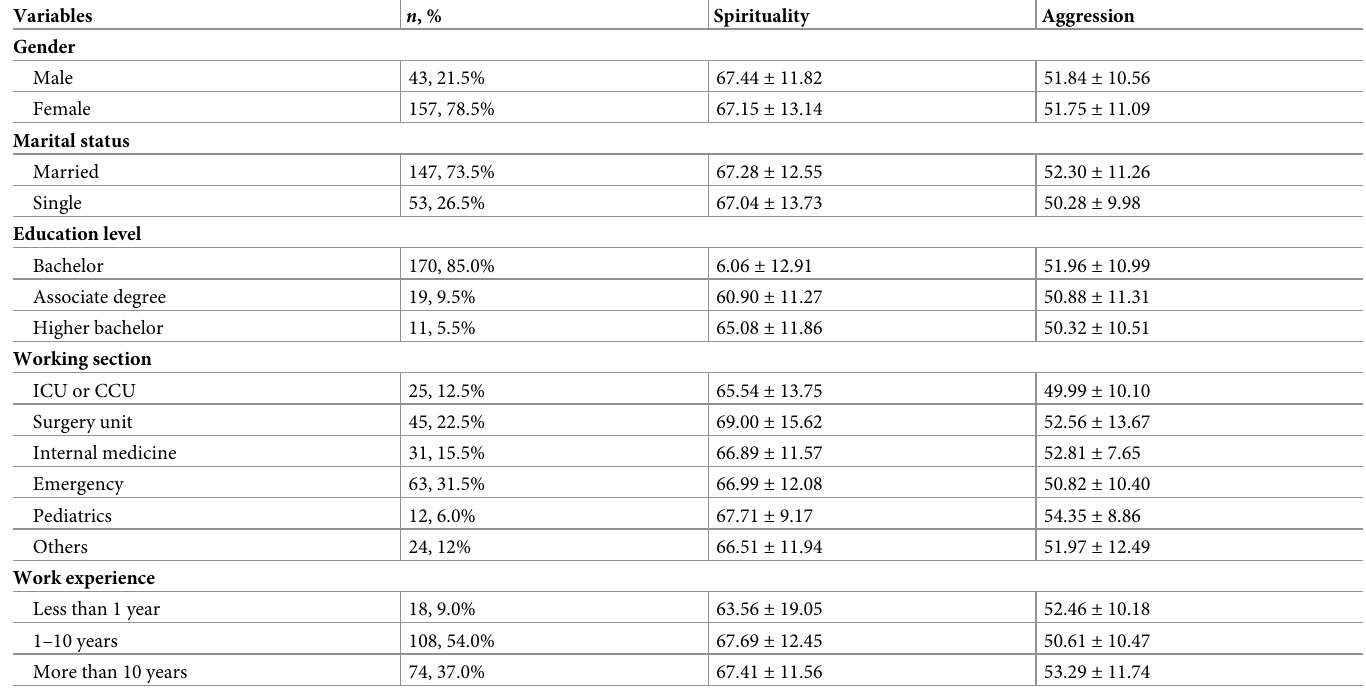
Table 1. Distribution of the socio-demographic variables with spiritual health and